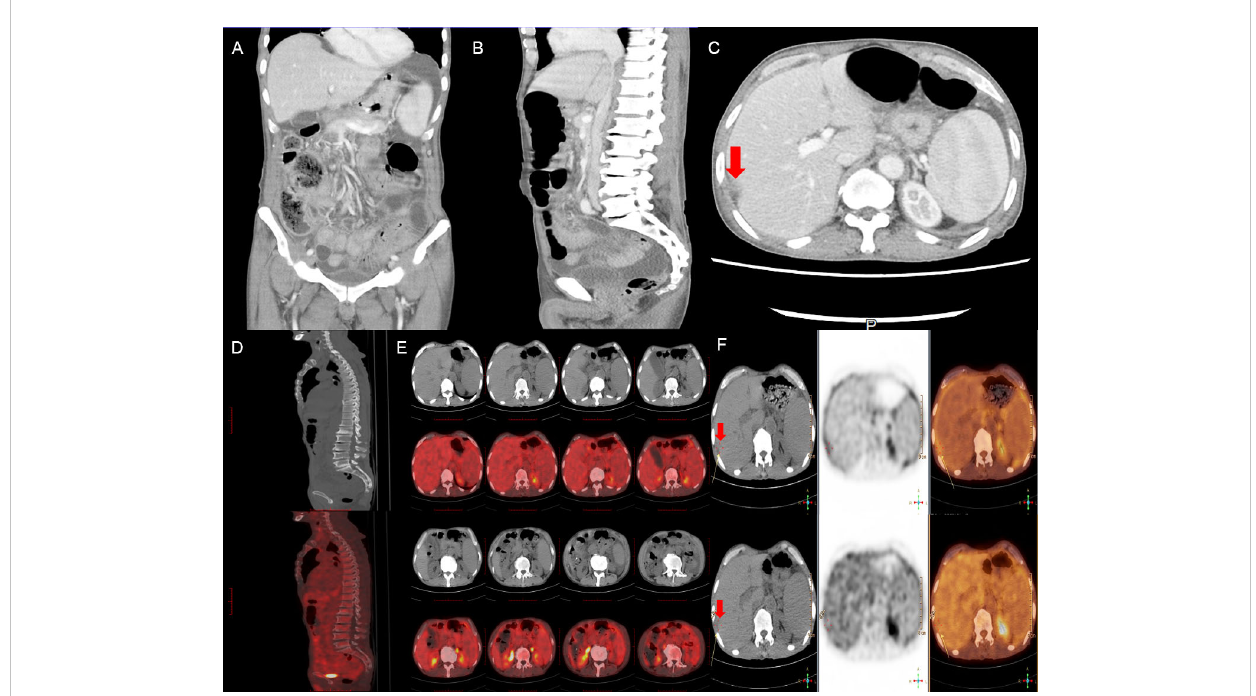
FIGURE 1 Contrast-enhanced abdominal CT (A-C) scan showed volumetric disproportion of lobar and segmental of the slightly enlarged liver with massive abdominal-pelvic fl uid accumulation. Full-body PET-CT scan (D-F) showed no signi fi cant hypermetabolism but a slightly low signal from the subcapsular area in the right hepatic lobe with ascites and splenomegaly. Red arrows point to the subcapsular area in the right hepatic lobe with